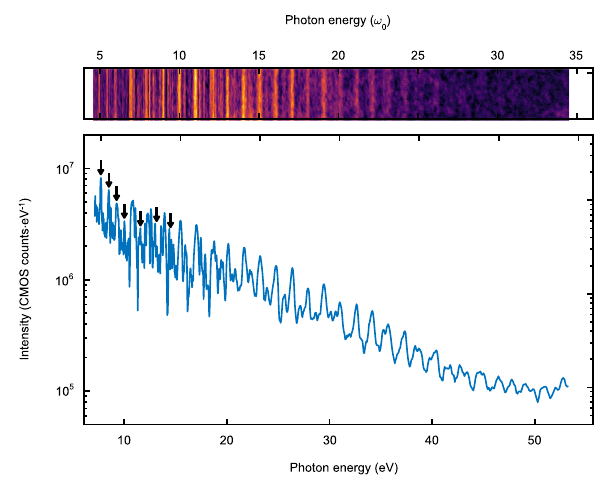
Fig. 5 | High-harmonic spectrum generated in the ROM regime using a liquid plasmamirror. Theupperpanelshowstheangle-resolvedspectrum,andthelower panel shows the angle-integrated HHG spectrum generated through ROM from a liquid plasma mirror. The black arrows denote the second-order diffraction of the harmonics.